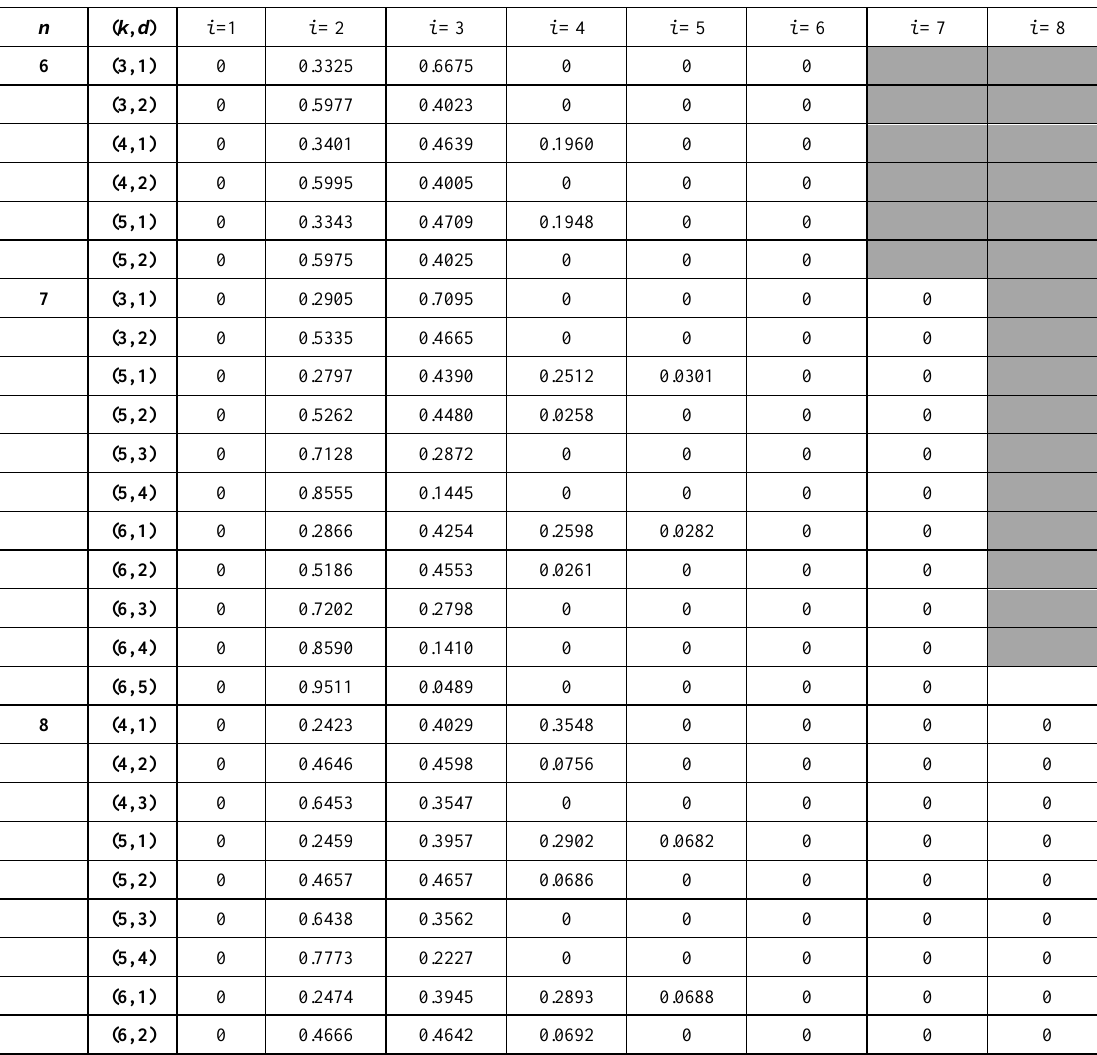
Table 2. The signatures of the constrained ( k , d ) − out − of − n : F system under several